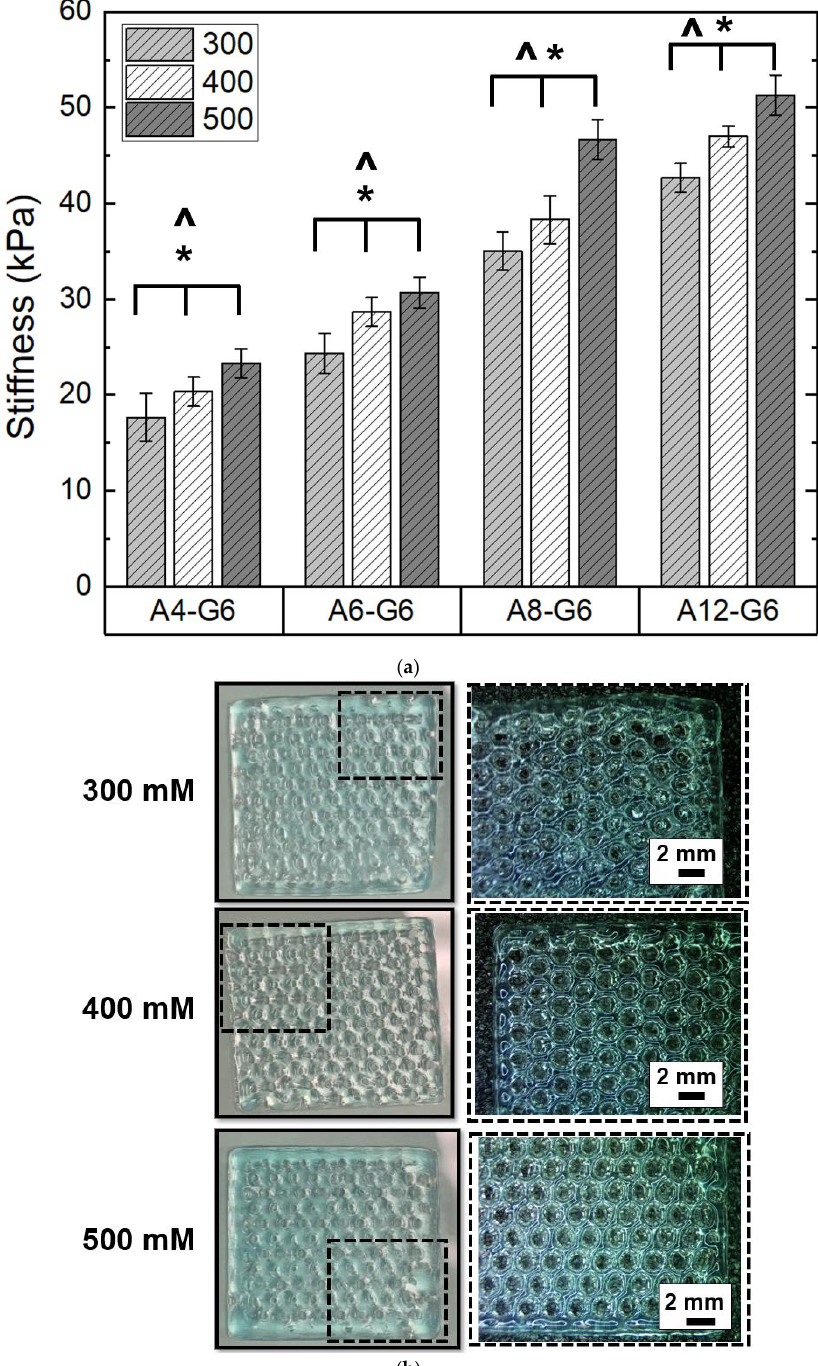
Figure 5. Effect of crosslinking concentration on the stiffness of the printed scaffolds. ( a ) Stiffness of the constructs when crosslinked with different calcium chloride (CaCl 2 ) concentrations and 15 min of crosslinking time. * indicates that at 0.05 level (two-way ANOVA), the mean stiffness of the scaffolds crosslinked with different crosslinking concentrations is significantly different. ˆ indicates that at the 0.05 level (two-way ANOVA), the mean stiffness of the scaffolds with different alginate concentrations is significantly different. ( b ) Digital images of the scaffolds (20 × 20 × 1 mm 3 ) indicate the effect of varying CaCl 2 concentrations on the printed scaffolds. The corresponding stereomicroscopy images show the magnified view of the dotted regions in the